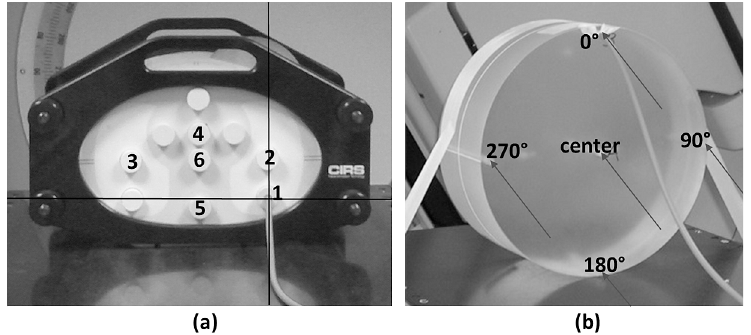
Fig 2. Setup and layout of different measurement positionsof (a) inhomogeneous thorax phantomfor patient simulation(1: tumor in lower left lung, 2: left lung, 3: right lung, 4: upper periphery,5: spinal cord, 6: body center), and (b) CT dose body phantomfor QA purposes.